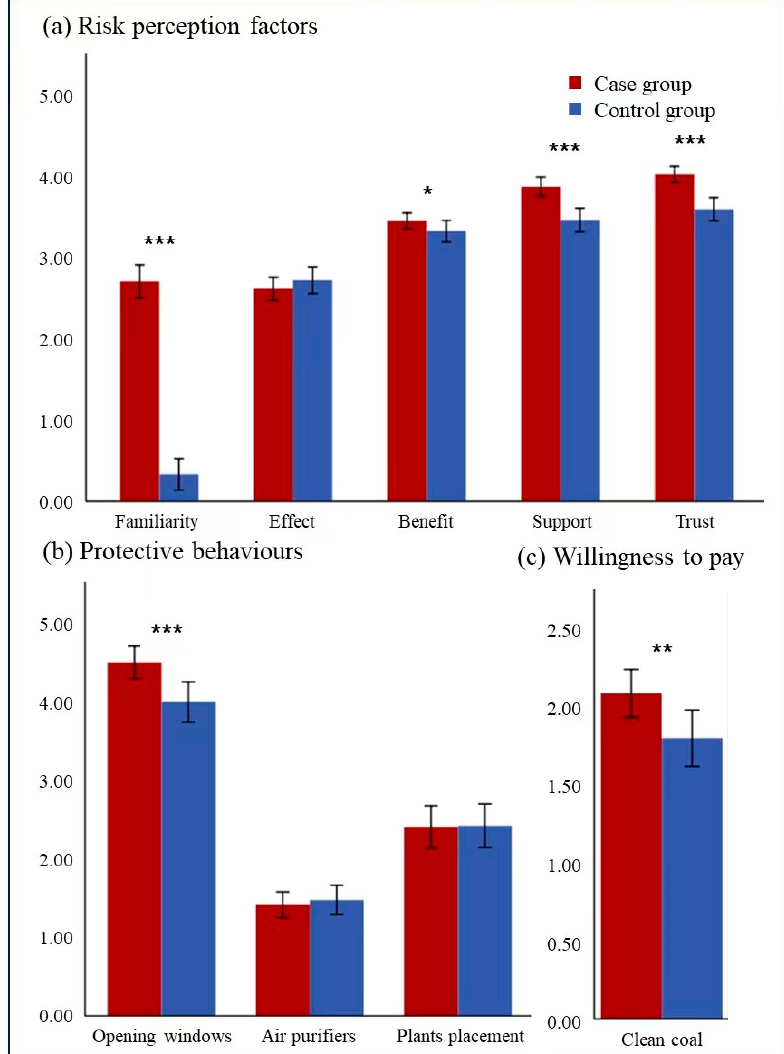
Figure 3. Comparison of ( a ) risk perception factors, ( b ) protective behaviors, and ( c ) willingness to pay between case group and control group. The error bars on the graph represent the standard deviation of the mean. *** p < 0.001, ** p < 0.01, * p < 0.05.